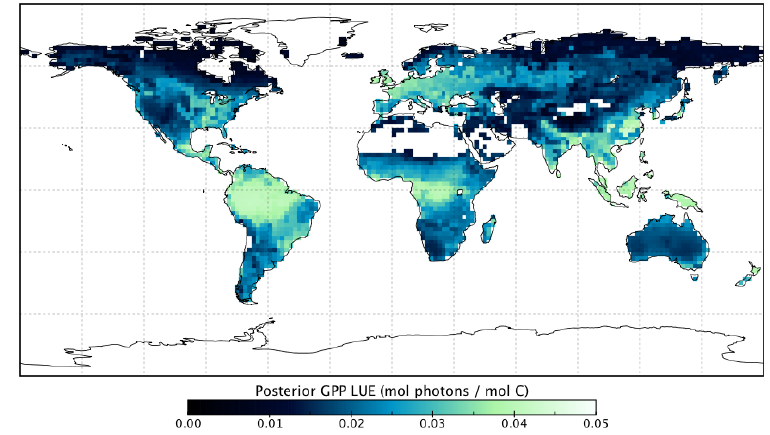
Figure B3. Posterior annual mean LUE GPP following the SIF assimilation.